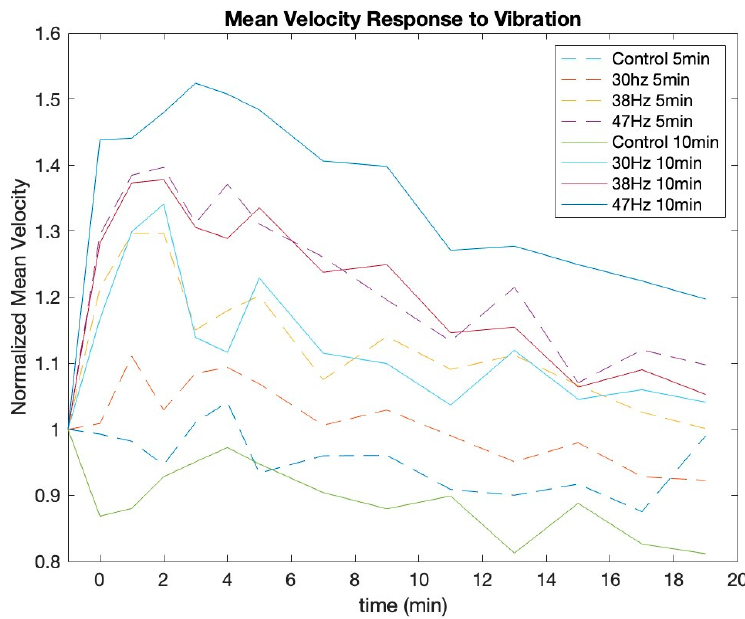
Figure 2. Normalized mean velocity response to each vibration condition.